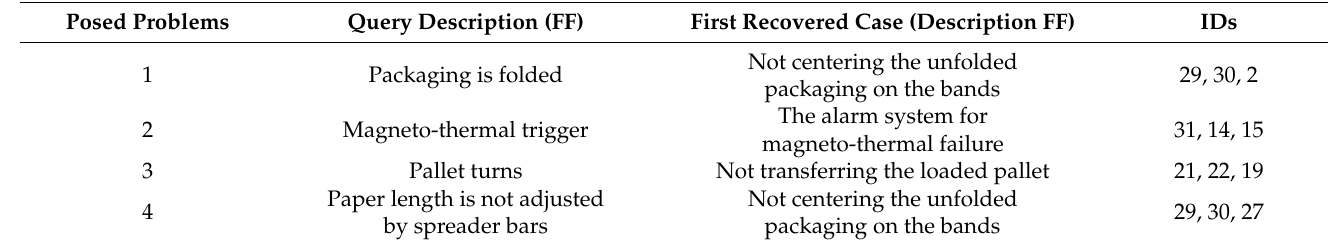
Table 4. Simulations of raised cases and similar cases